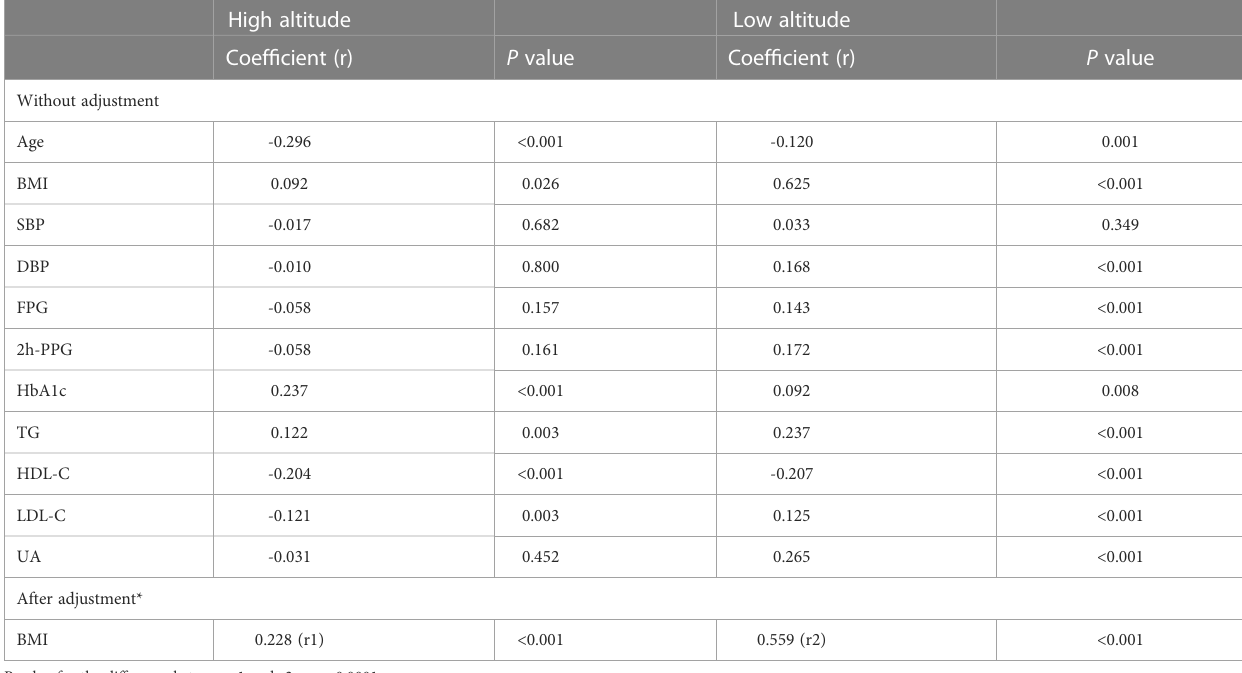
TABLE 3 Correlation between Ln (leptin) and different variables of native women living at high and low altitude. High